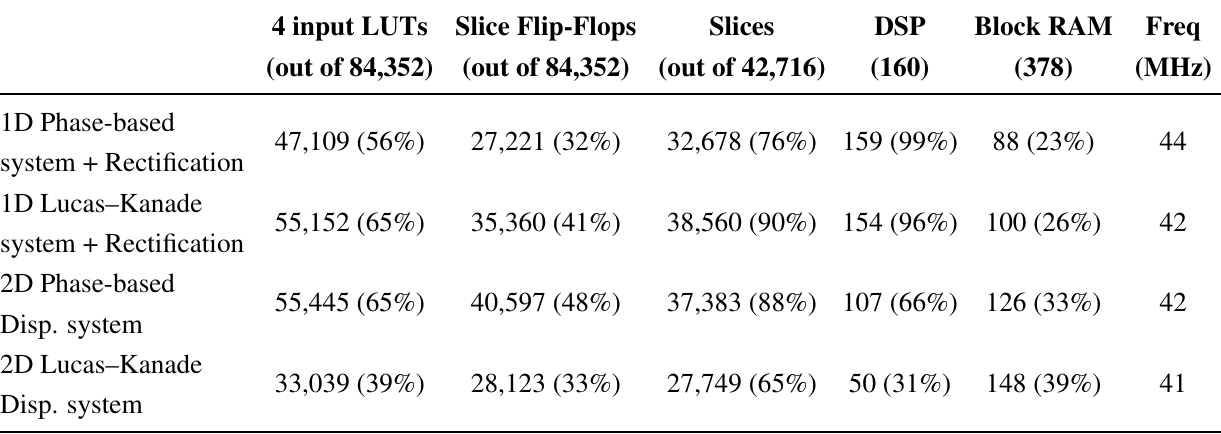
Table 4. Hardware resource utilization for the presented complete architecture using